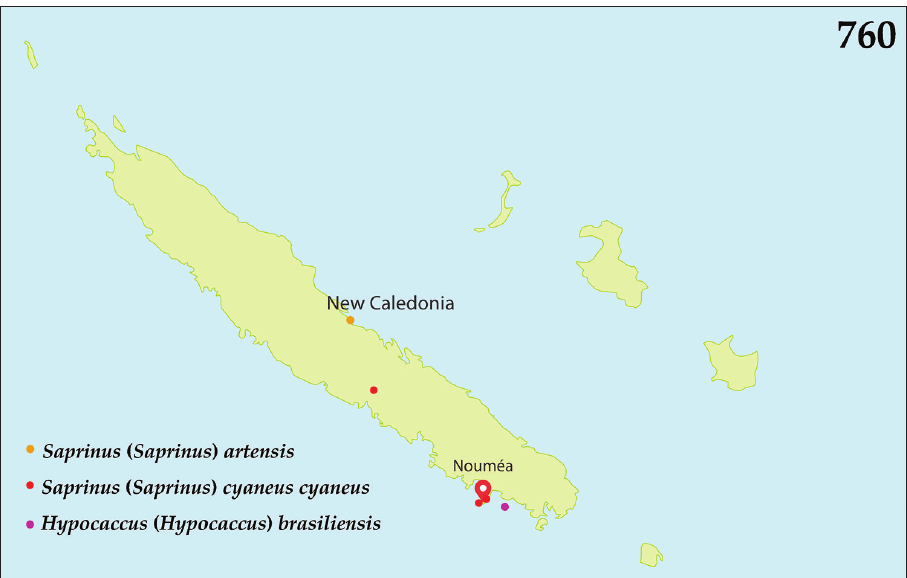
Figure 760. Distribution of Saprininae on New Caledonia: Saprinus ( Saprinus ) cyaneus cyaneus (Fabricius, 1775); Saprinus ( Saprinus ) artensis Marseul, 1862 and Hypocaccus ( Hypocaccus ) brasiliensis (Paykull,